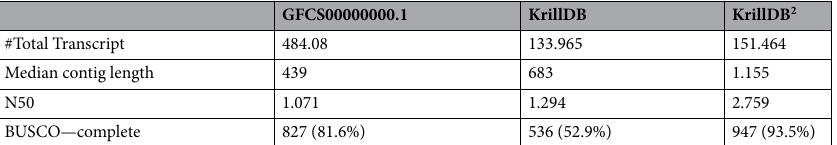
Table 3. Quality statistics of the previously released krill transcriptomes compared to the newly assembled KrillDB 2 . GenBank accession GFCS00000000.1 refers to the SuperbaSe krill transcriptome reference 19